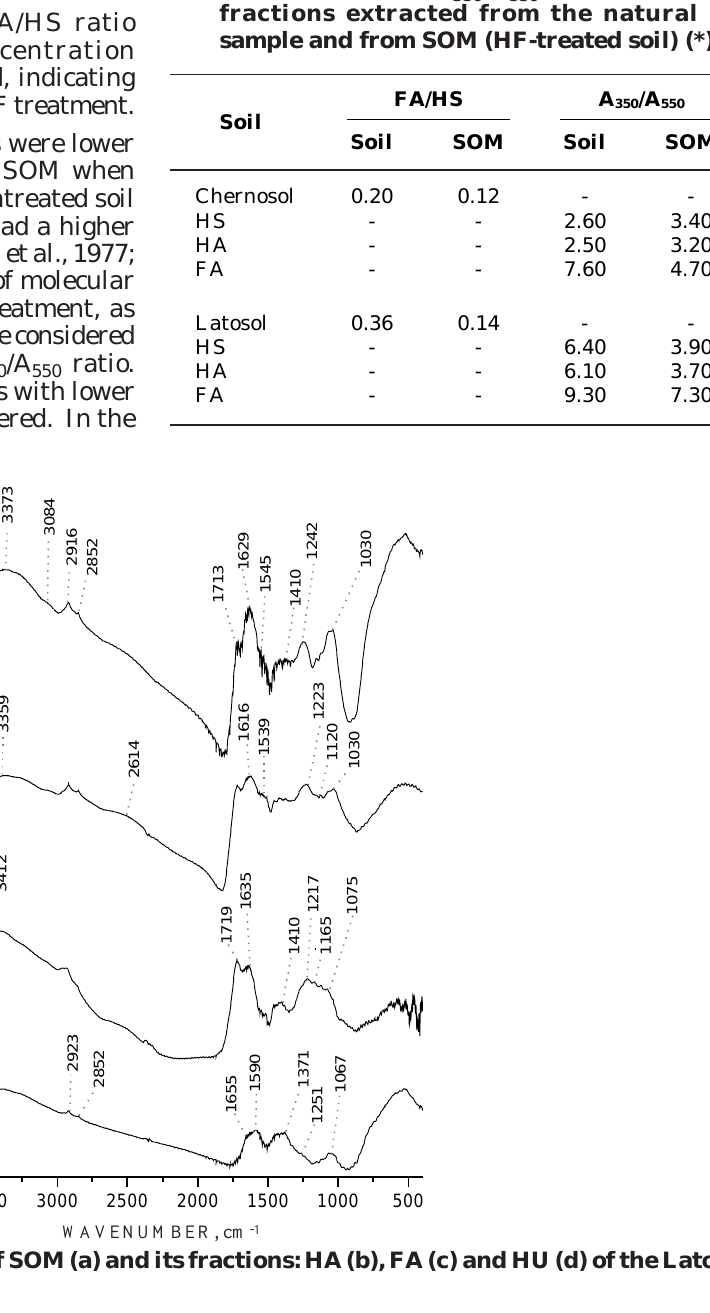
Table 2. FA/HS and A fractions extracted from the natural